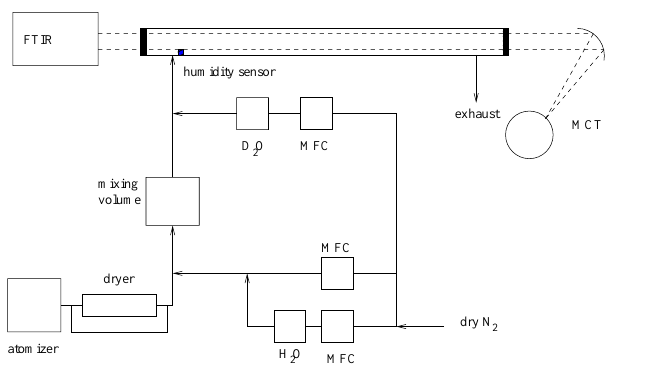
Figure 2. Experimental setup. An atomizer was used to pro- duce particles in an aqueous or crystalline state after removal of condensed-phase water in a dryer. H 2 O or D 2 O vapor could then be added to the system from two bubblers coupled to mass flow con- trollers. The IR spectrum of the aerosol was then determined in a FTIR-coupled flow tube.